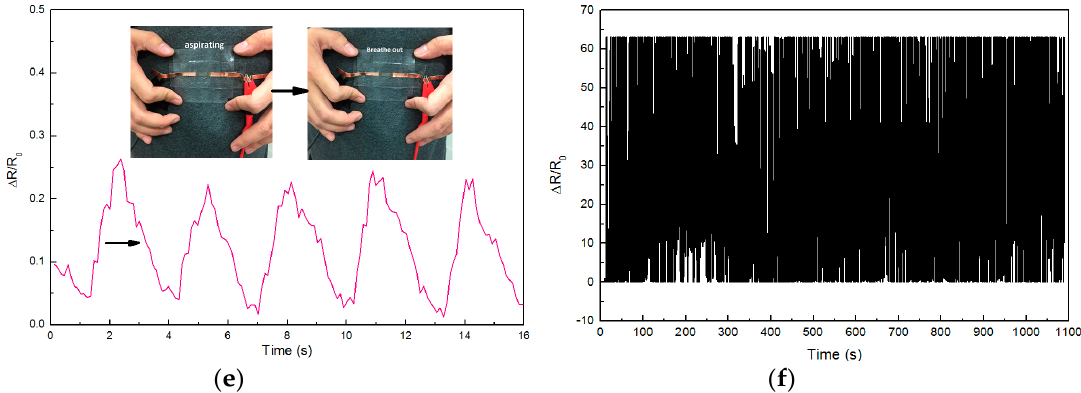
Figure 8. Body movement sensing of ( a ) arm motion detection results of rotation; ( b ) wrist bending; ( c ) motion detection results of elbow bending; ( d ) heart beat; ( e ) breath; ( f ) Δ R/R 0 as a function of multiple stretching and releasing cycles with 22% strain forAg@CNTs1-based sensor.